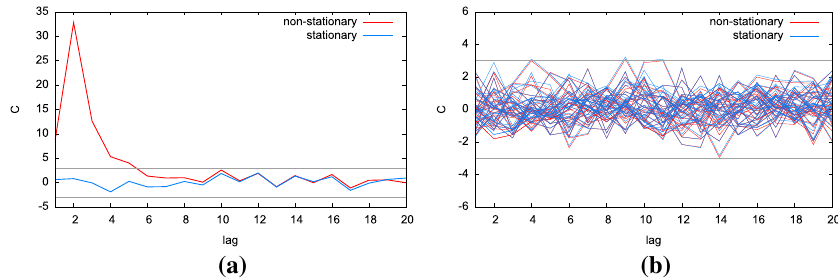
Fig. 71 Autocorrelation of the whitened Fourier coefficients as a function of lag for stationary and locally- stationary AR ( 1 ) models. Panel a is a comparison for the full data sets, and panel b is for each of the 32 sub-segments. The locally-stationary data show clear departures from stationarity in the full data set, but are consistent with stationarity in the shorter sub-segments of